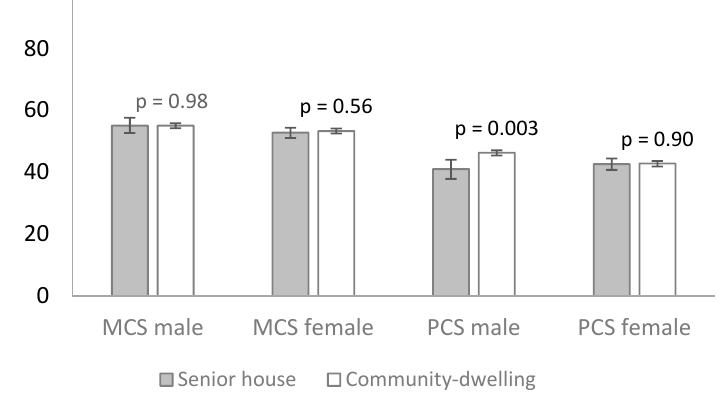
Figure 1. The SF-36 physical and mental functioning summary scores for males and females in housing groups using General Linear Model (GLM) adjusted for age, educational attainment, marital status and economic situation. MCS = mental component summary score, PCS = physical component summary score.